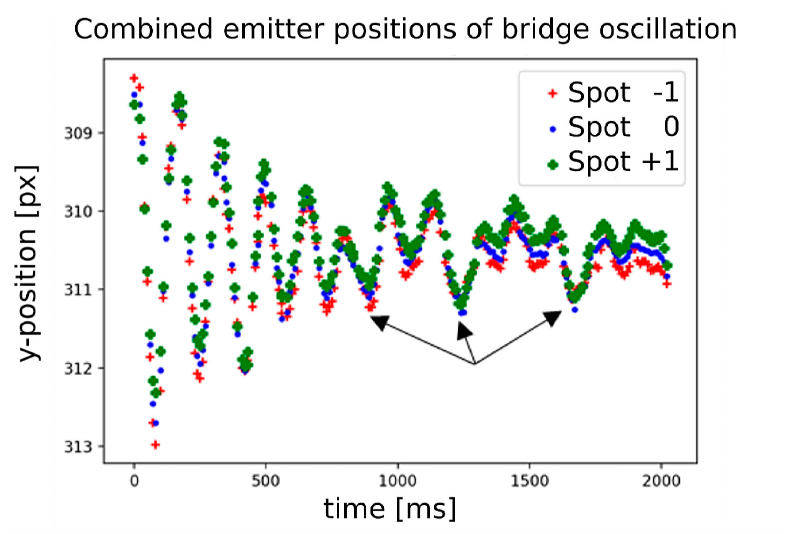
Figure 8. Oscillations for high frequency force application. The arrows depict moments when additional external excitation of the bridge was performed (by jumping). Compare Figure 9 for the spectrum of the